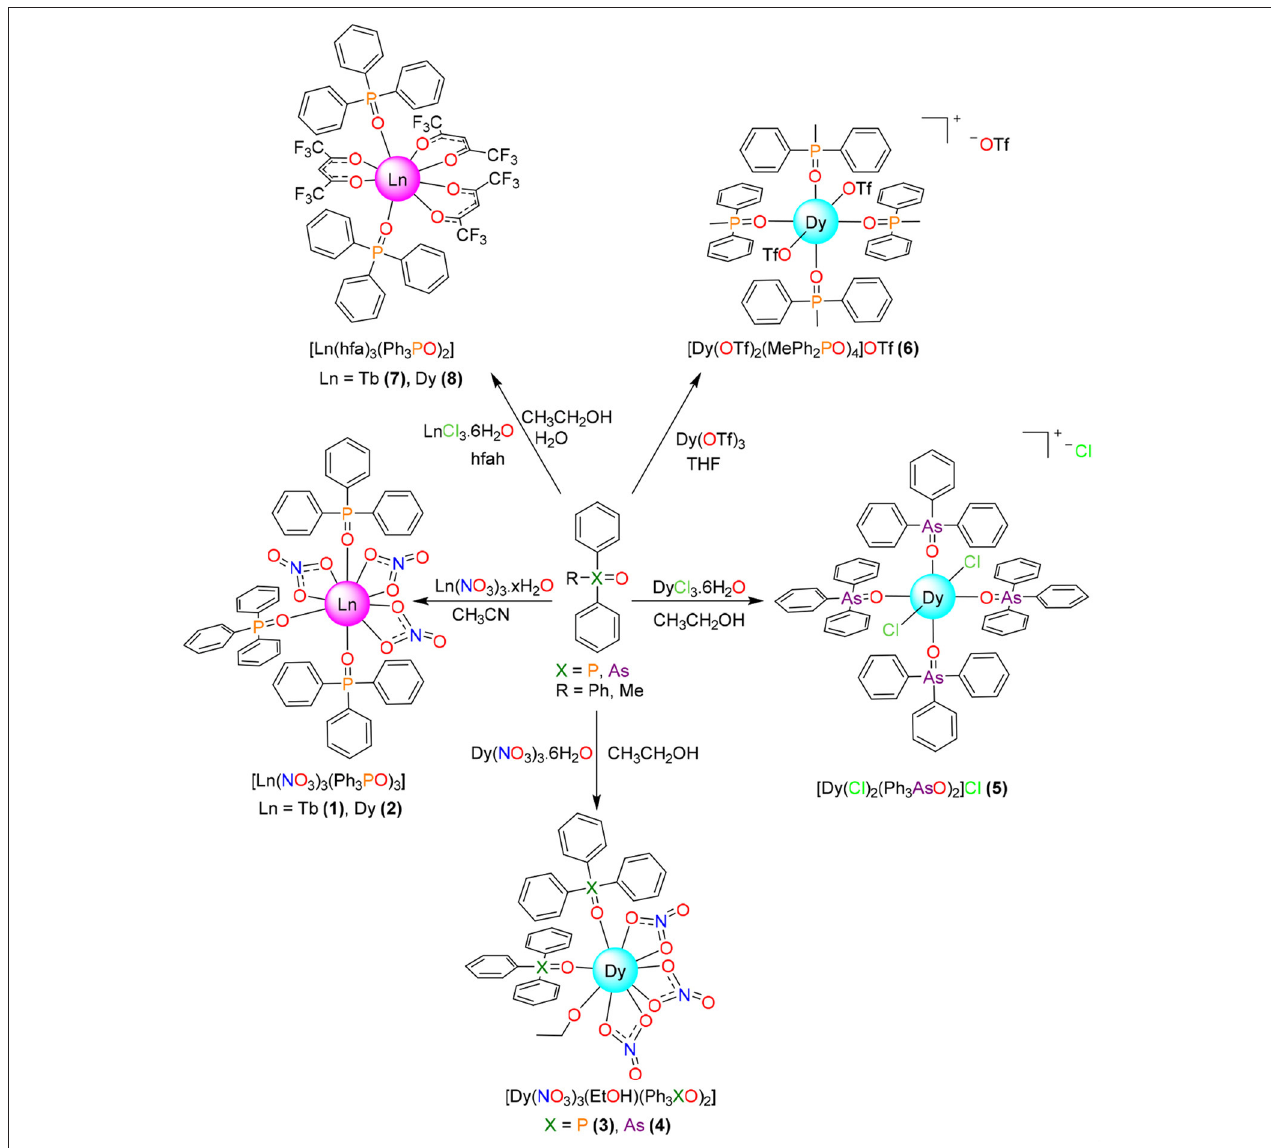
FIGURE 1 | Reaction scheme for isolation of the metal